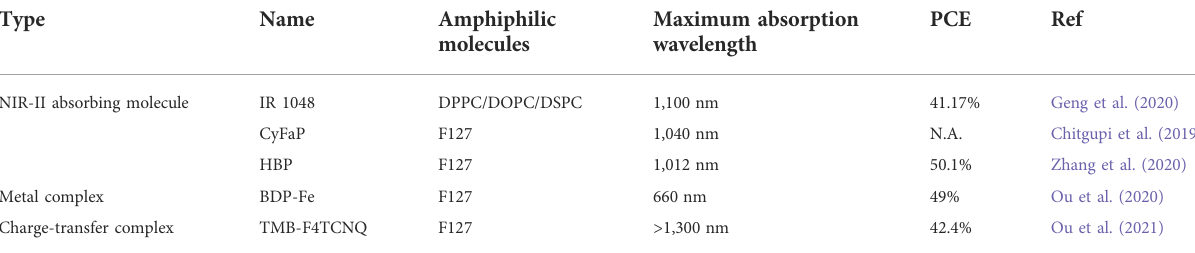
TABLE 1 Summary of small molecule-based contrast agents for NIR-II PA